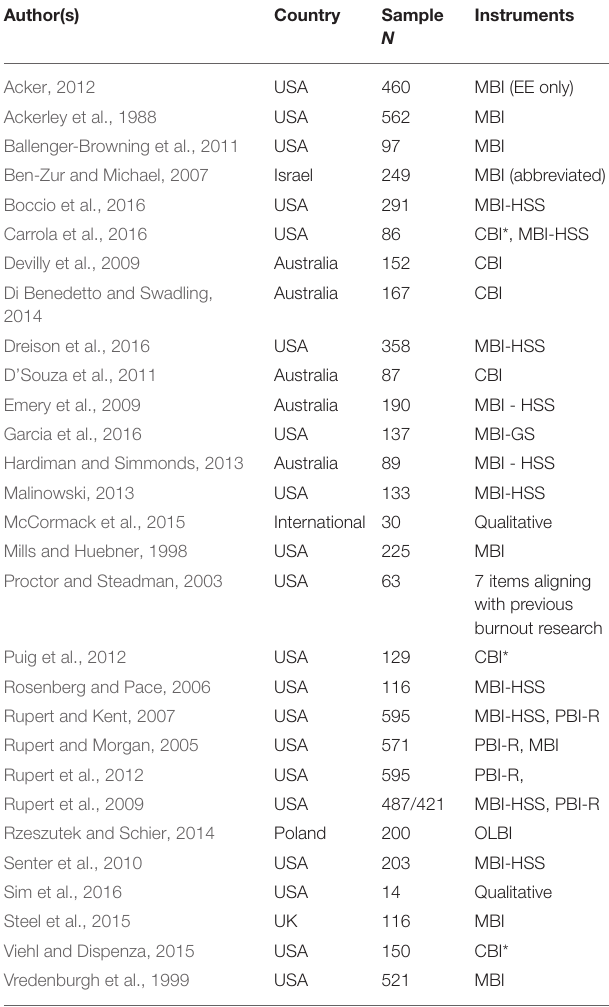
TABLE 2 | Burnout measurements used by papers included in